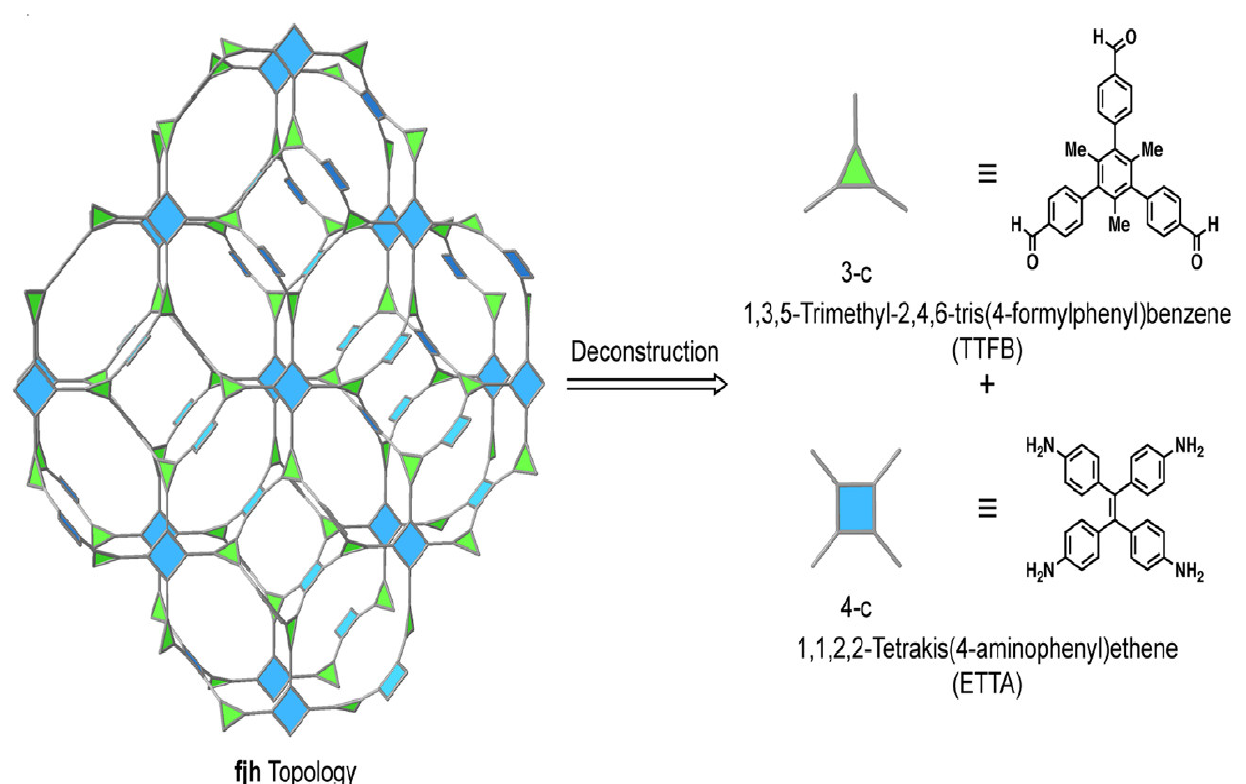
Figure 3. Synthesis of 3D COF with fjh topology. Reprinted (adapted) with permission from [34]. Copyright 2020 American Chemical Society.